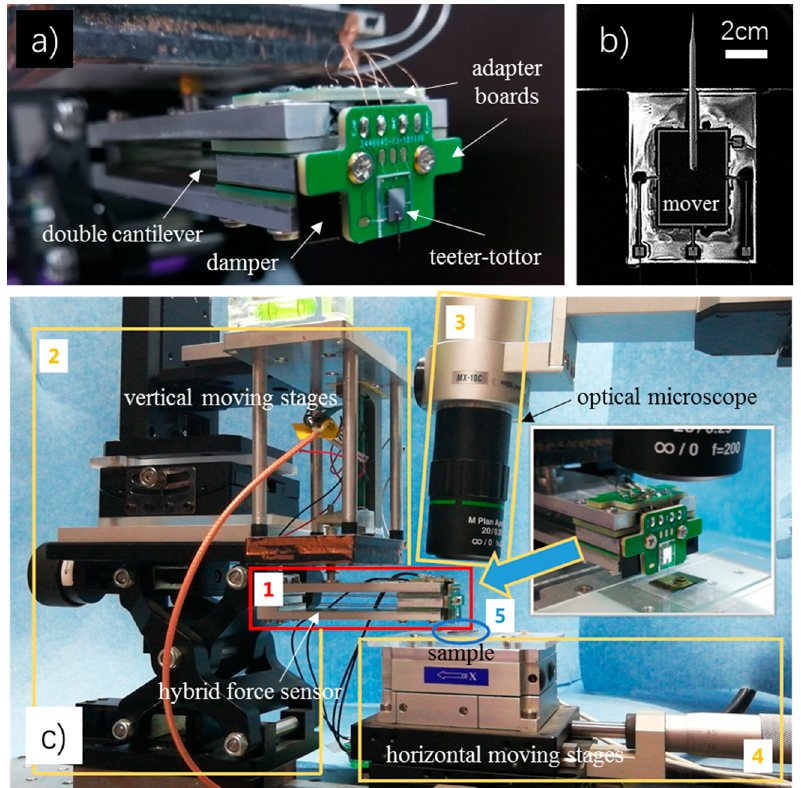
Figure 6. Photos of the sensor and the test system. ( a ) A photo of the hybrid two-axis force sensor; ( b ) A SEM picture of the micro teeter-totter sensing part; ( c ) A photo of the test system. 1-the hybrid force sensor, 2-vertical moving stages, 3-optical microscope (Hirox), 4-horizontal moving stages, 5-a test sample. The inset picture at the upper right corner is a close look at the microscope, the sample, the lateral force sensor and the adapter boards.